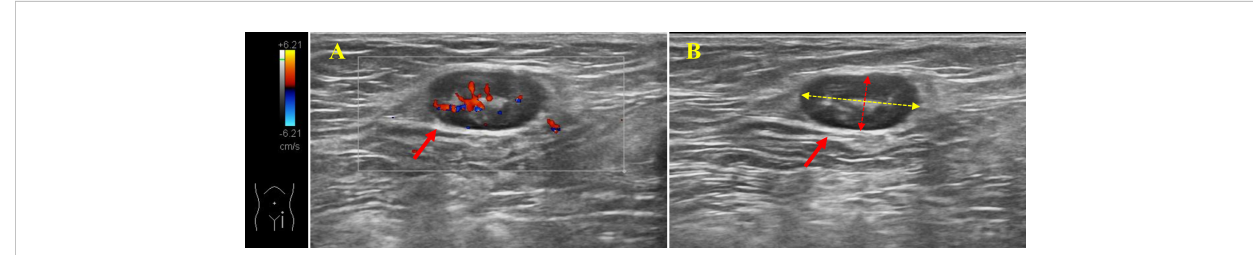
FIGURE 2 Ultrasonography of inguinal lymph nodes. (A) : Color Doppler shows enlarged blood supply in lymph nodes in the inguinal region. (B) : Measurements of the long and short axes of the lymph nodes. Solid red arrows: lymph nodes; Yellow dotted arrow: long axis of lymph node; Red dotted arrow: short axis of lymph